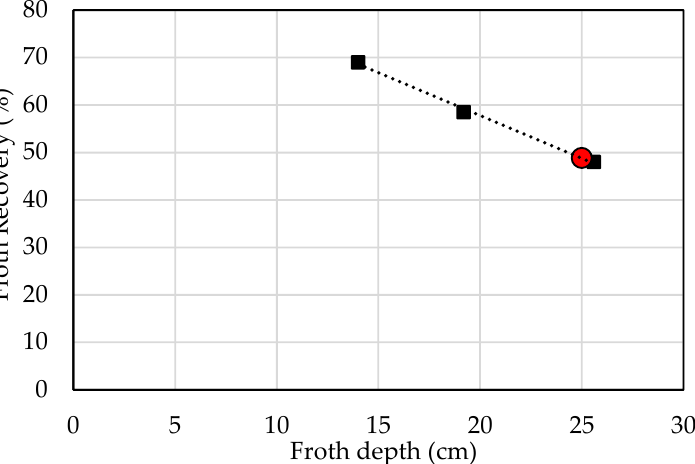
Figure 4. Froth recovery vs. froth depth in the TankCell ® e630: data reported by Suhonen et al. [22] and this work (red point).